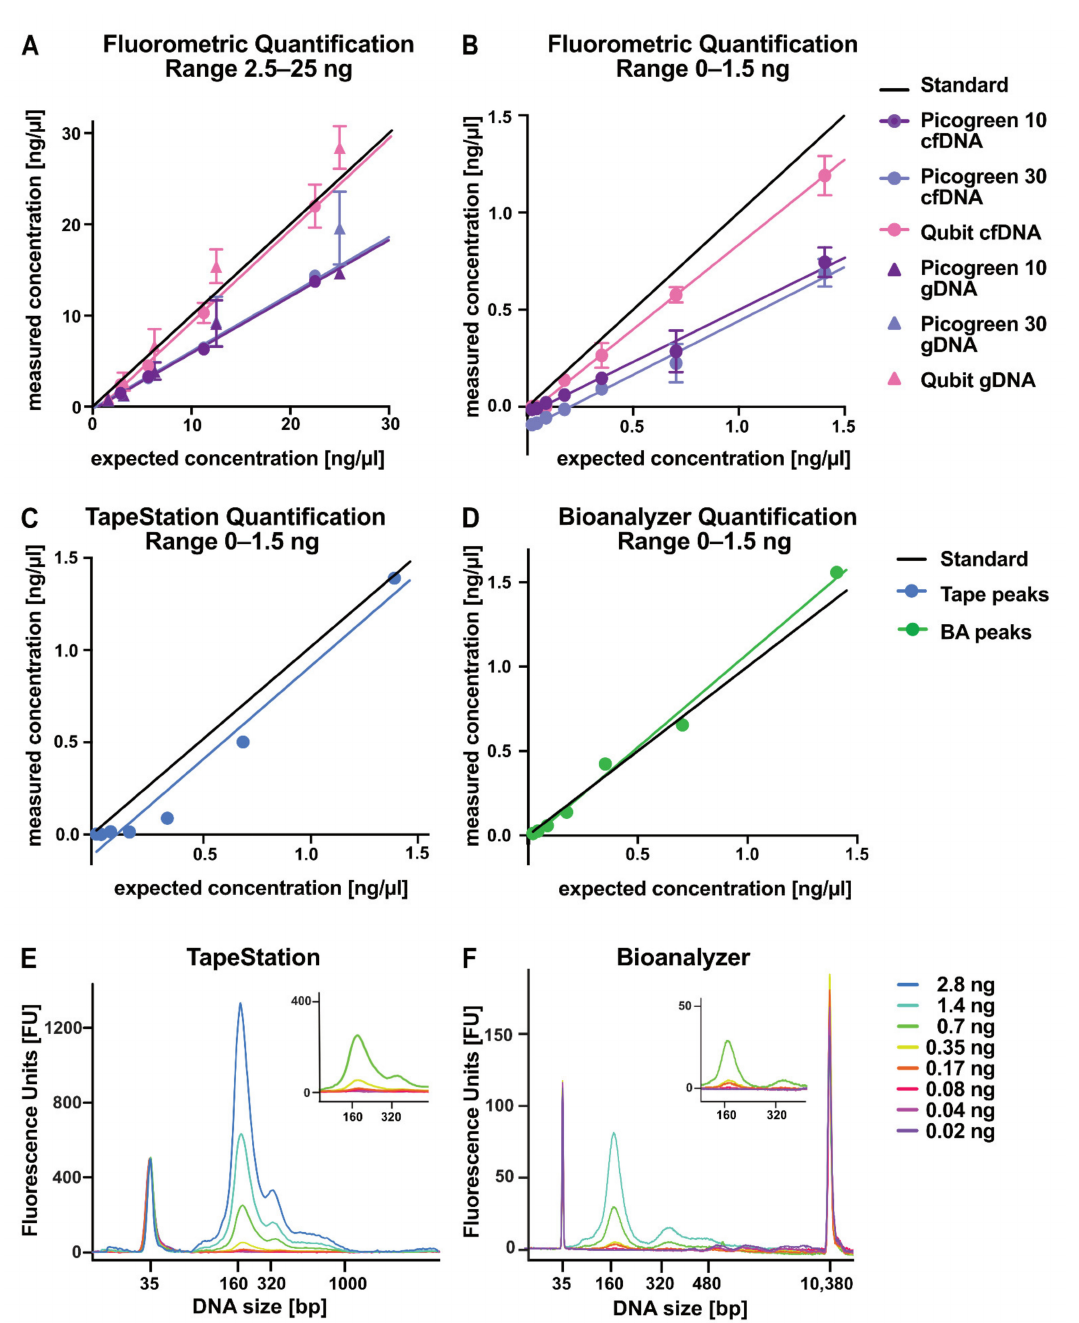
Figure 4. Evaluation of sensitivity and reproducibility of DNA quantification methods in low concentration range. ( A , B ) Cor- relation of expected to measured concentration of genomic DNA (gDNA) and cell-free DNA (cfDNA) quantified by flu- orometric measurement methods ( n = 5). ( A ) gDNA and cfDNA concentration in the range of 2.5–25 ng/ µ L. ( B ) The range of 0–1.5 ng/ µ L is indicated only for cfDNA values. ( C , D ) Quantification of cfDNA by electrophoretic quantification methods. ( C ) cfDNA of indicated concentrations were run on TapeStation cfDNA screen tapes and quantified for the peak region. ( D ) cfDNA of indicated concentrations were run on Bioanalyzer (BA) chip and the observed peaks were quantified. ( E ) Overlay of corresponding TapeStation cfDNA profiles of indicated concentration (0.02–2.8 ng) quantified in ( C ). In the upper right corner: zoom-in of the TapeStation profiles ≤ 700 pg. ( F ) Overlay of corresponding BA cfDNA profiles of indicated concentrations (0.0–21.4 ng) quantified in ( D ). In the upper right corner: zoom-in of the BA profiles ≤ 700 pg. All whiskers represent the standard deviation of technical